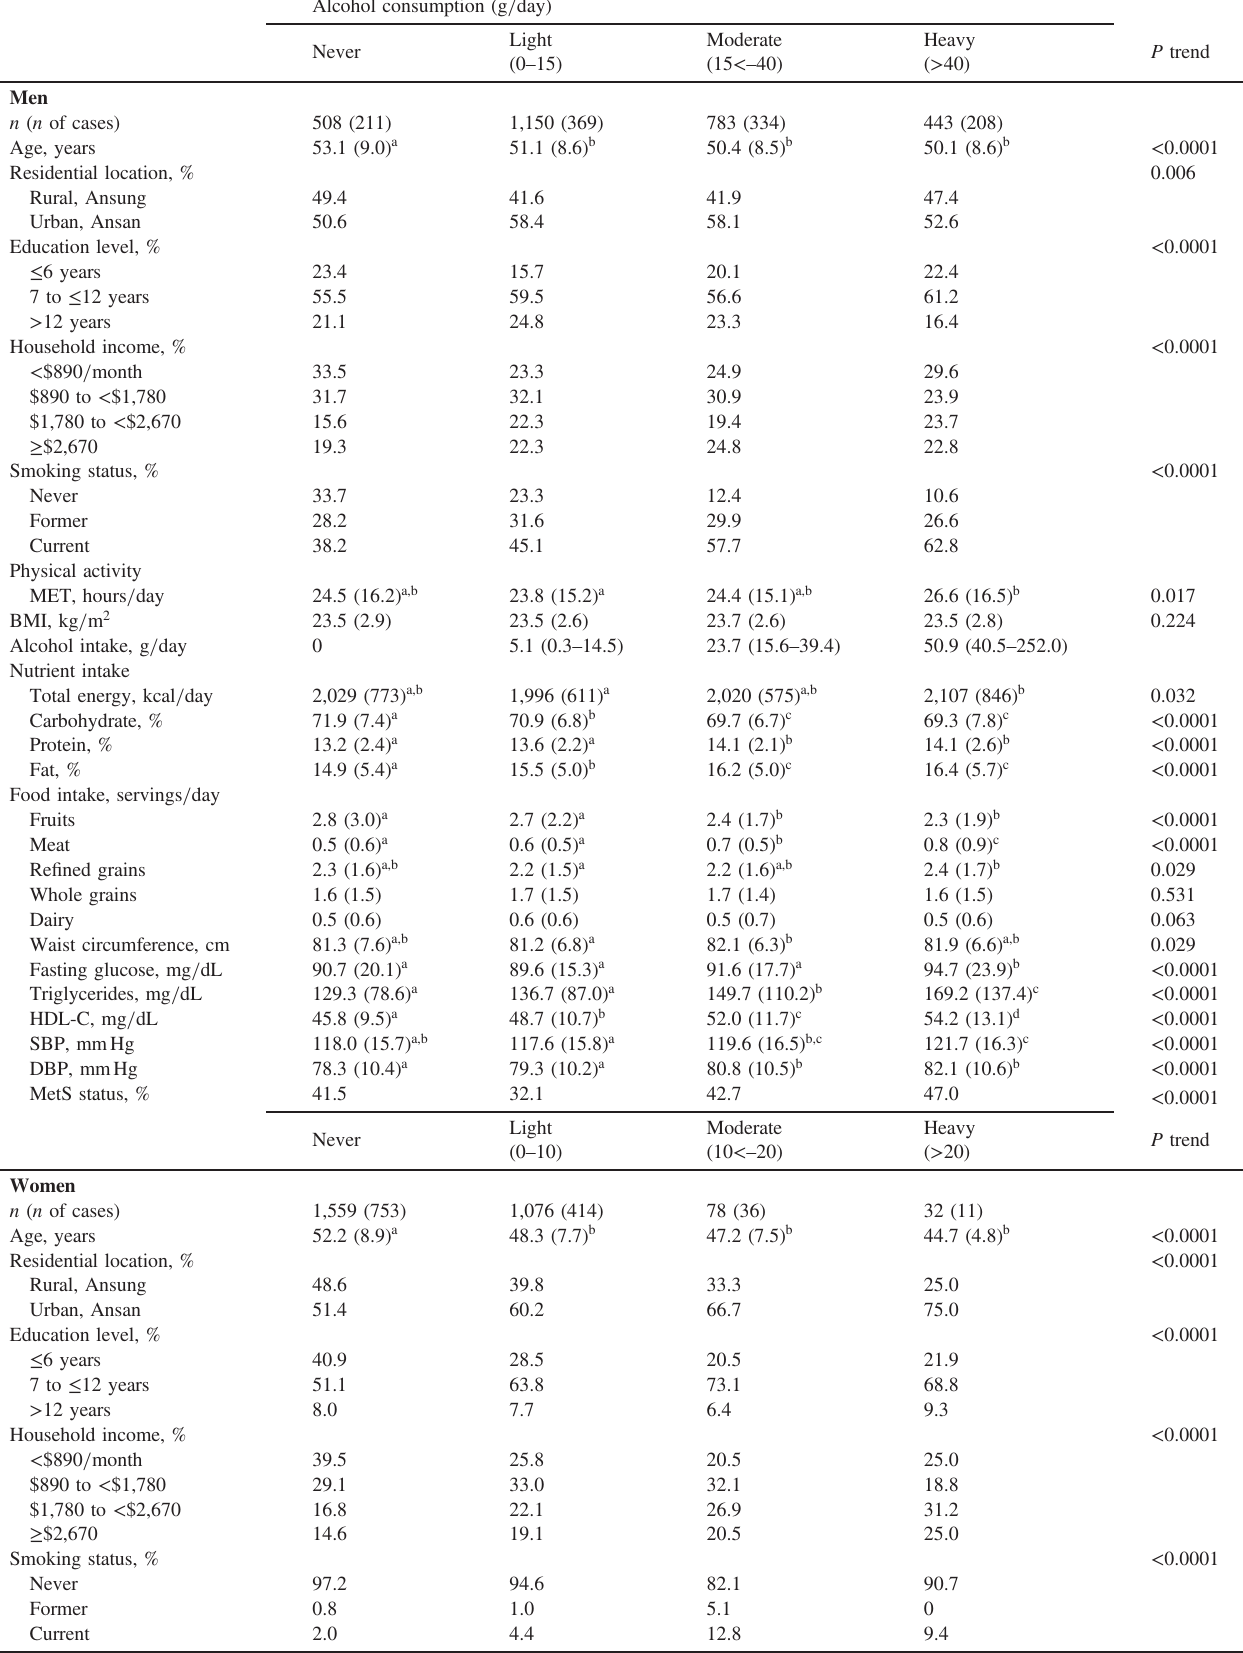
Table 2. Baseline characteristics of Korean adults according to alcohol consumption by sex